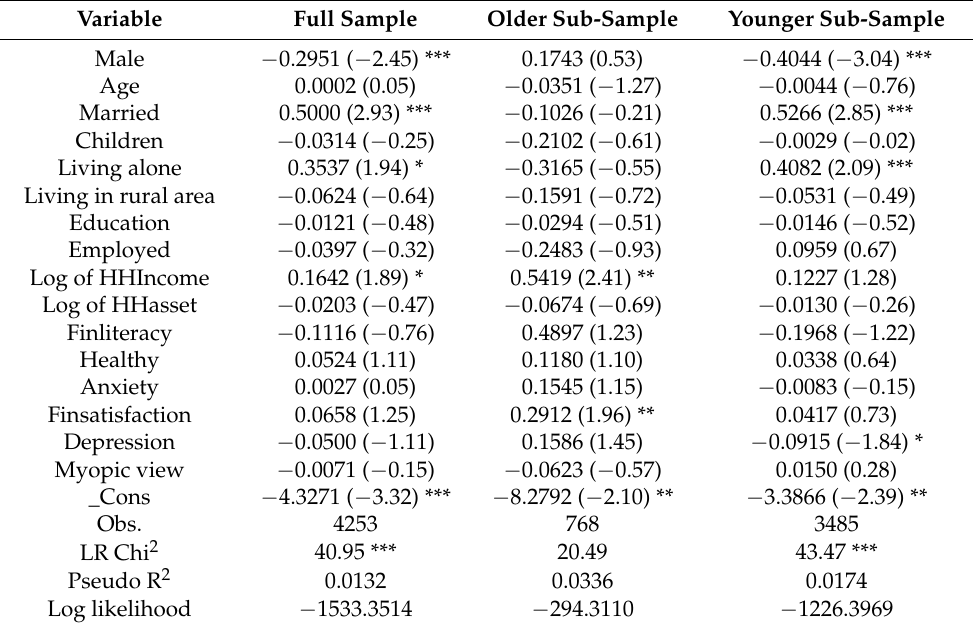
Table 7. Logit regression analysis for loneliness among respondents during the COVID-19 pandemic who were not lonely